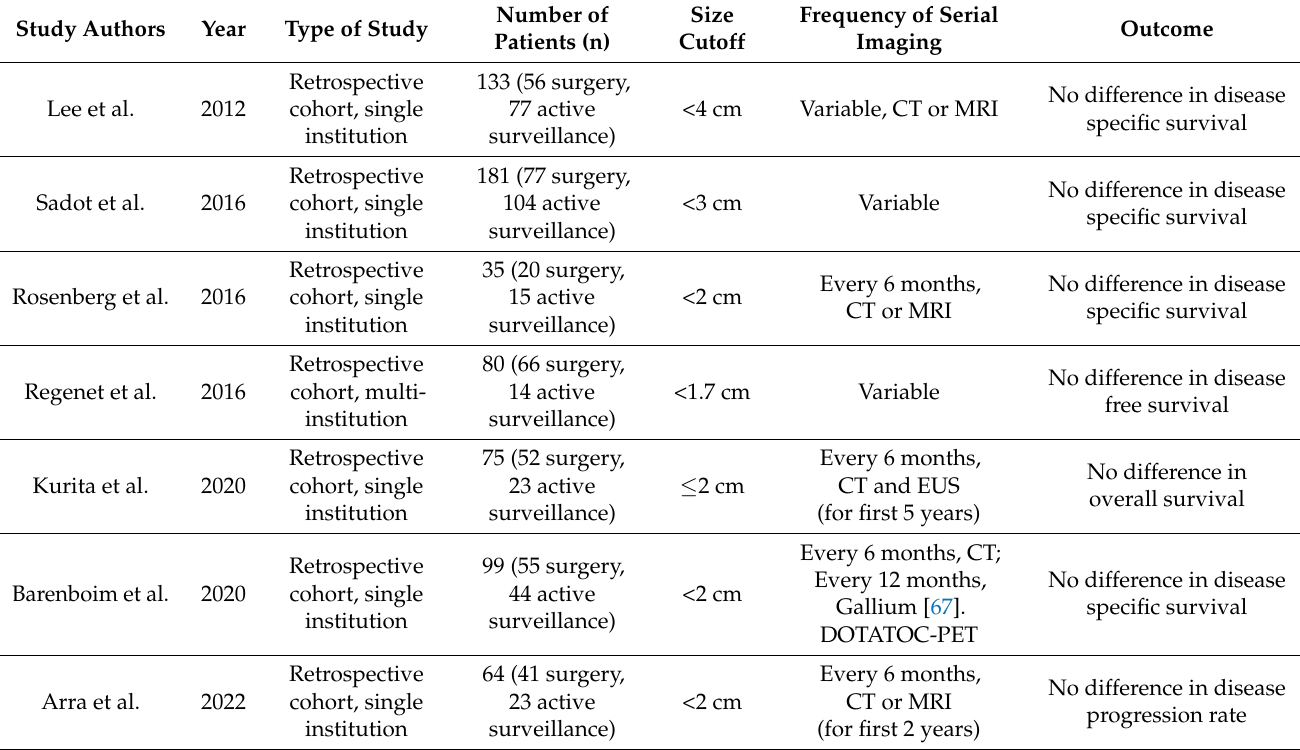
Table 2. Retrospective studies evaluating size cutoff value for nonfunctional PNETs’ active